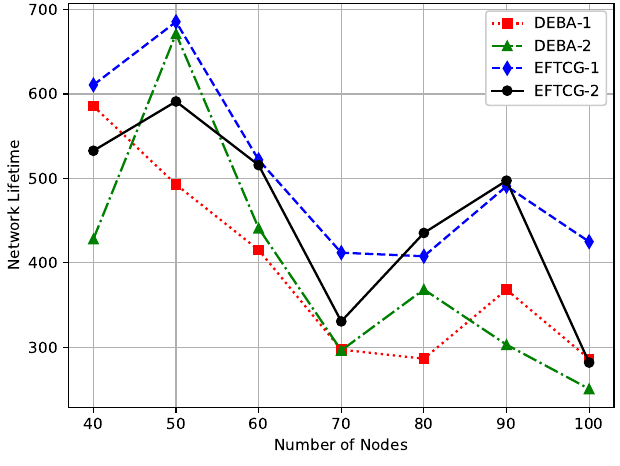
Figure 14. The network